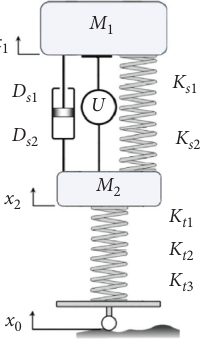
Figure 1: Schematic view of active quarter-car suspension